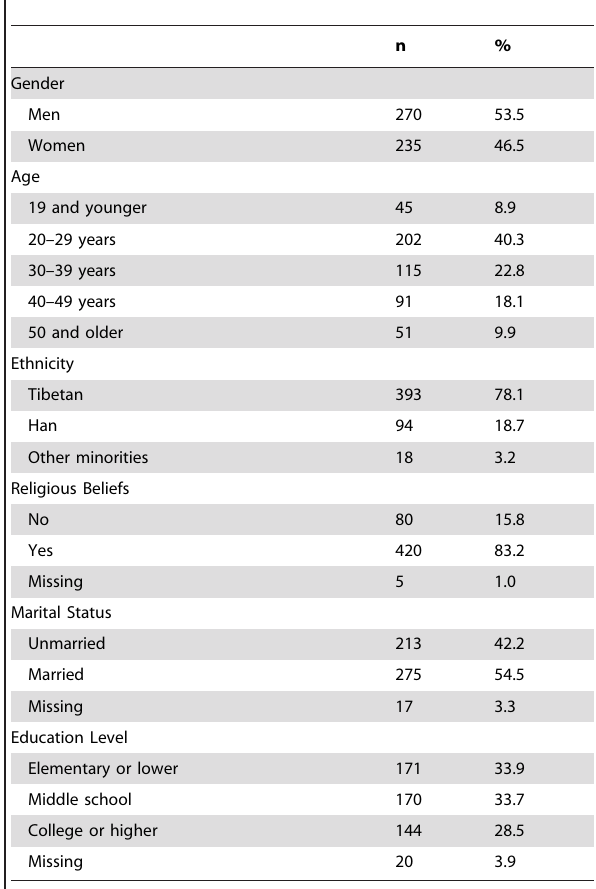
Table 1. Participant demographic information